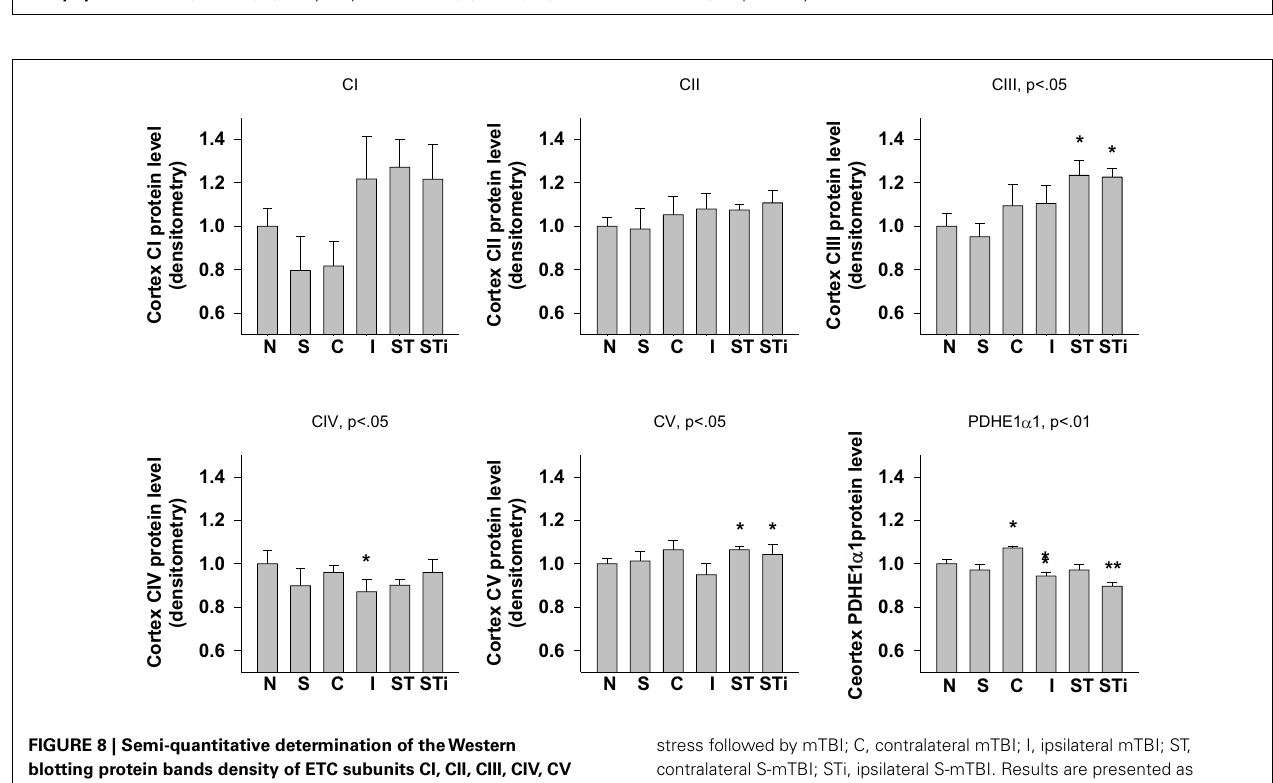
stress followed by mTBI; C, contralateral mTBI; I, ipsilateral mTBI; ST, contralateral S-mTBI; STi, ipsilateral S-mTBI. Results are presented as the fold change relative to the Naïves ( = 1). * p < 0.05, ** p < 0.01 vs. Naïves, respectively.